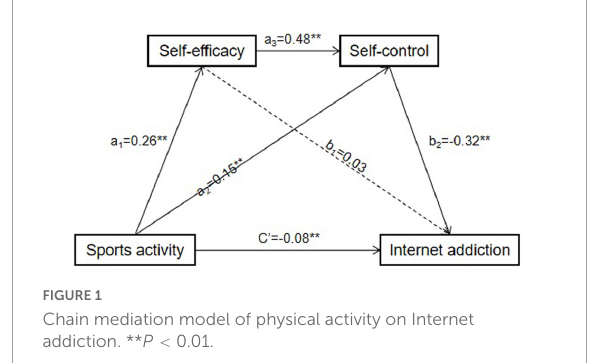
FIGURE1 Chain mediation model of physical activity on Internet addiction. ** P <